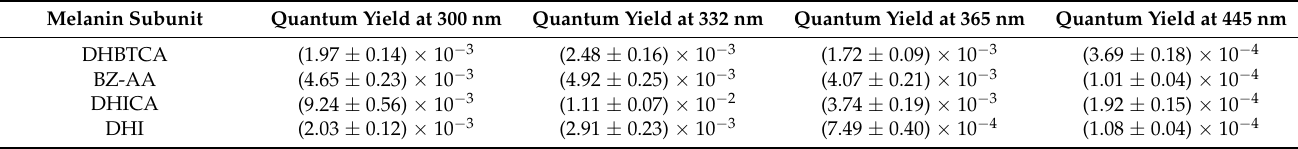
Table 2. Quantum yields of singlet oxygen photogeneration at different wavelengths for melanin subunits and their quenching rate constants. Data represent mean ±